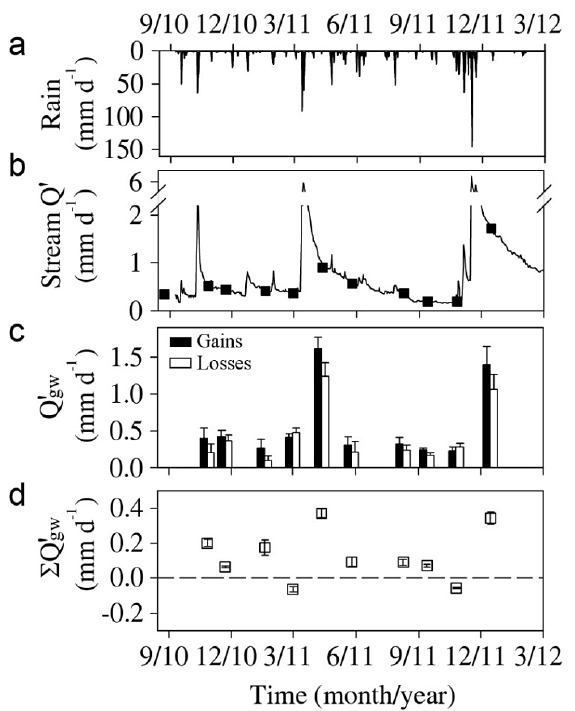
Figure 2. Temporal pattern of area-specific (a) rainfall, (b) stream discharge, (c) whole-reach gross hydrological gains and losses, and (d) cumulative net groundwater inputs at the downstream-most site. Black squares in (b) are dates of field campaigns. Error bars in (c) and (d) show the uncertainty associated with the empirical estima- tion of Q from tracer slug additions. Error bars in (b) are smaller than the symbol